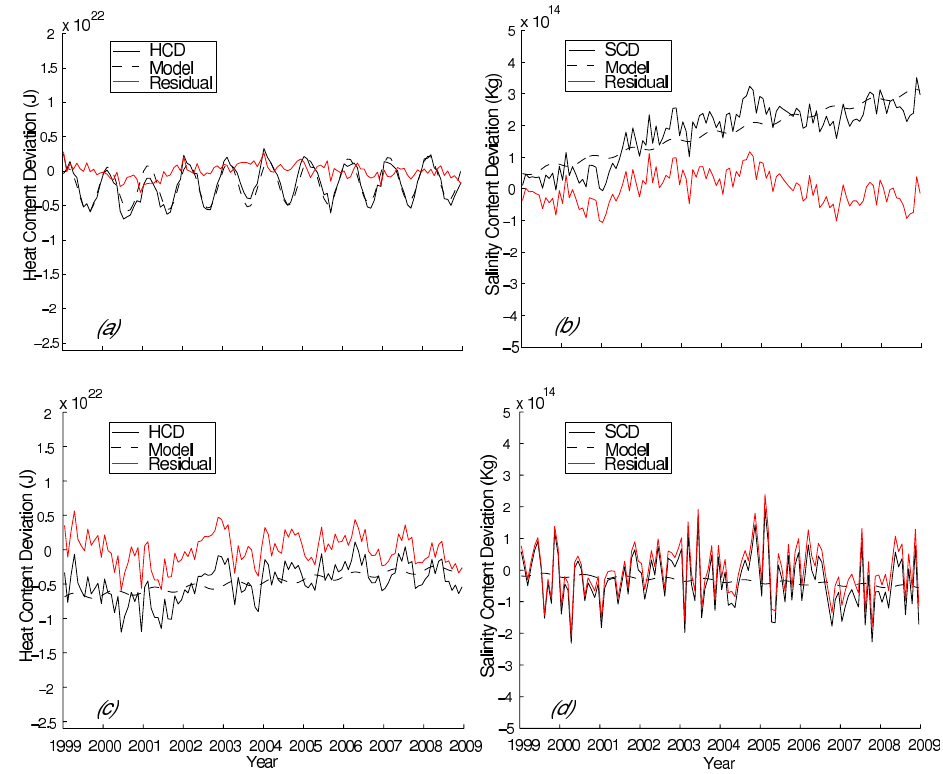
Fig. 7. Heat and salinity contents deviations, LTPO model and residual part: (a) HCD for the whole basin between 0 and 100m; (b) – SCD for the whole basin between 0 and 100m; (c) – HCD for the whole basin between 100 and 500m; (d) – SCD for the whole basin between 100 and 500m; Table 1. HCD for the whole basin between 0 and 2000m; the uncertainty is at the 95% confidence level. HCD Trend in LT Trend in LTPO Amplitude 10 20 J PVE 10 20